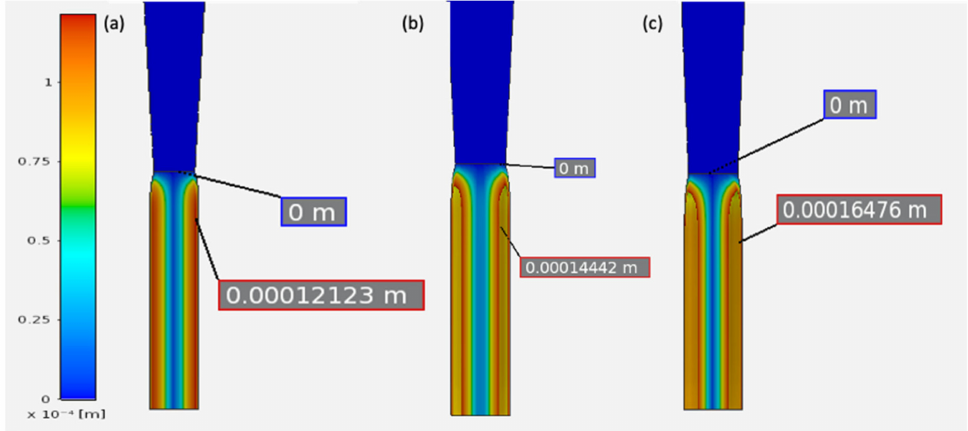
Figure 13. Die swell analysis of rice paste extrudate with different nozzle sizes: ( a ) nozzle size 0.8 mm,